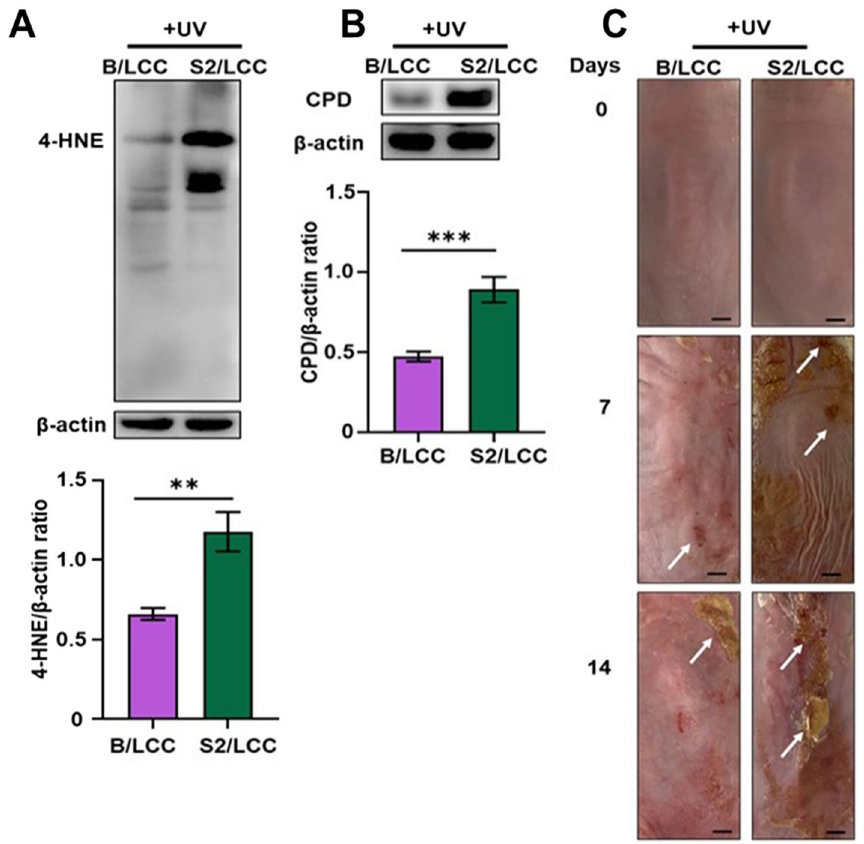
Figure 5. The UV-B-induced formation of 4-HNE, CPD and lesions in mouse skin applied with LCC in combination with S. epidermidis S2 isolate. The dorsal skin of ICR mice was topically applied with S. epidermidis ATCC 12228 (B/LCC) or S. epidermidis S2 (S2/LCC) in the presence of 2% LCC. The levels of ( A ) 4-HNE, ( B ) CPD related to β-actin in western blot analysis and ( C ) lesions (at 0, 7, and 14 days post-irradiation) on mouse skin irradiated with 100 mJ/cm 2 UV-B (+ UV) were shown. Skin lesions were indicated by white arrows. Data are the mean ± SD from three separate experiments. ** P < 0.01; *** P < 0.001 (two-tailed